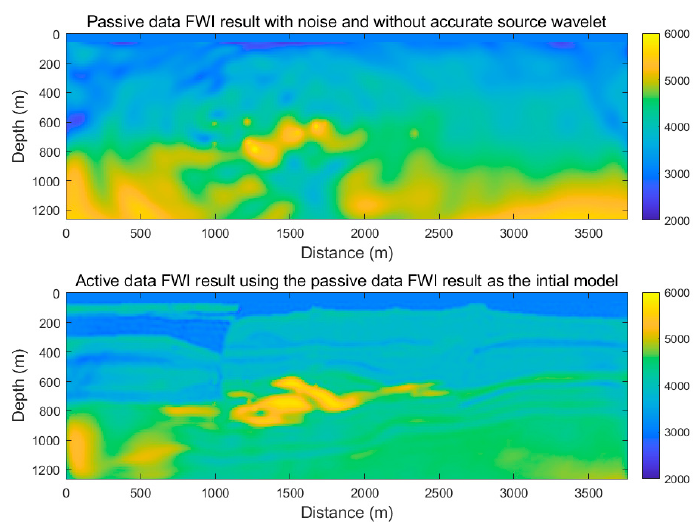
Figure 11. The source independent multisource FWI results of the noise datasets with less